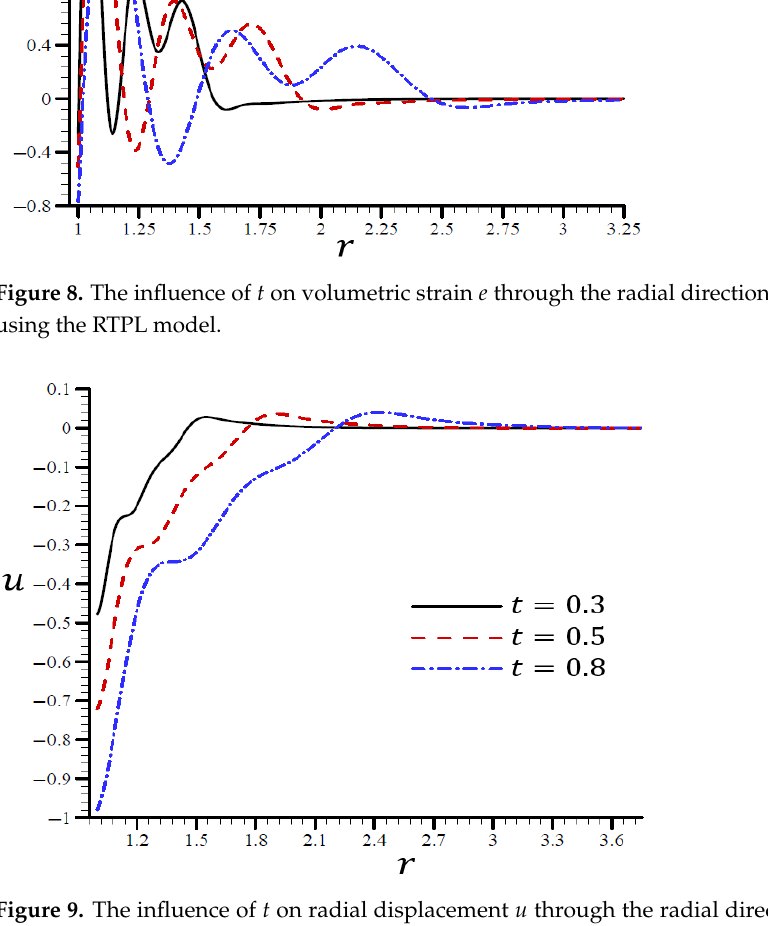
Figure 10. The influence of 𝑡 on radial stress 𝜎 𝑟𝑟 through the radial direction of the spherical hole using the RTPL model.